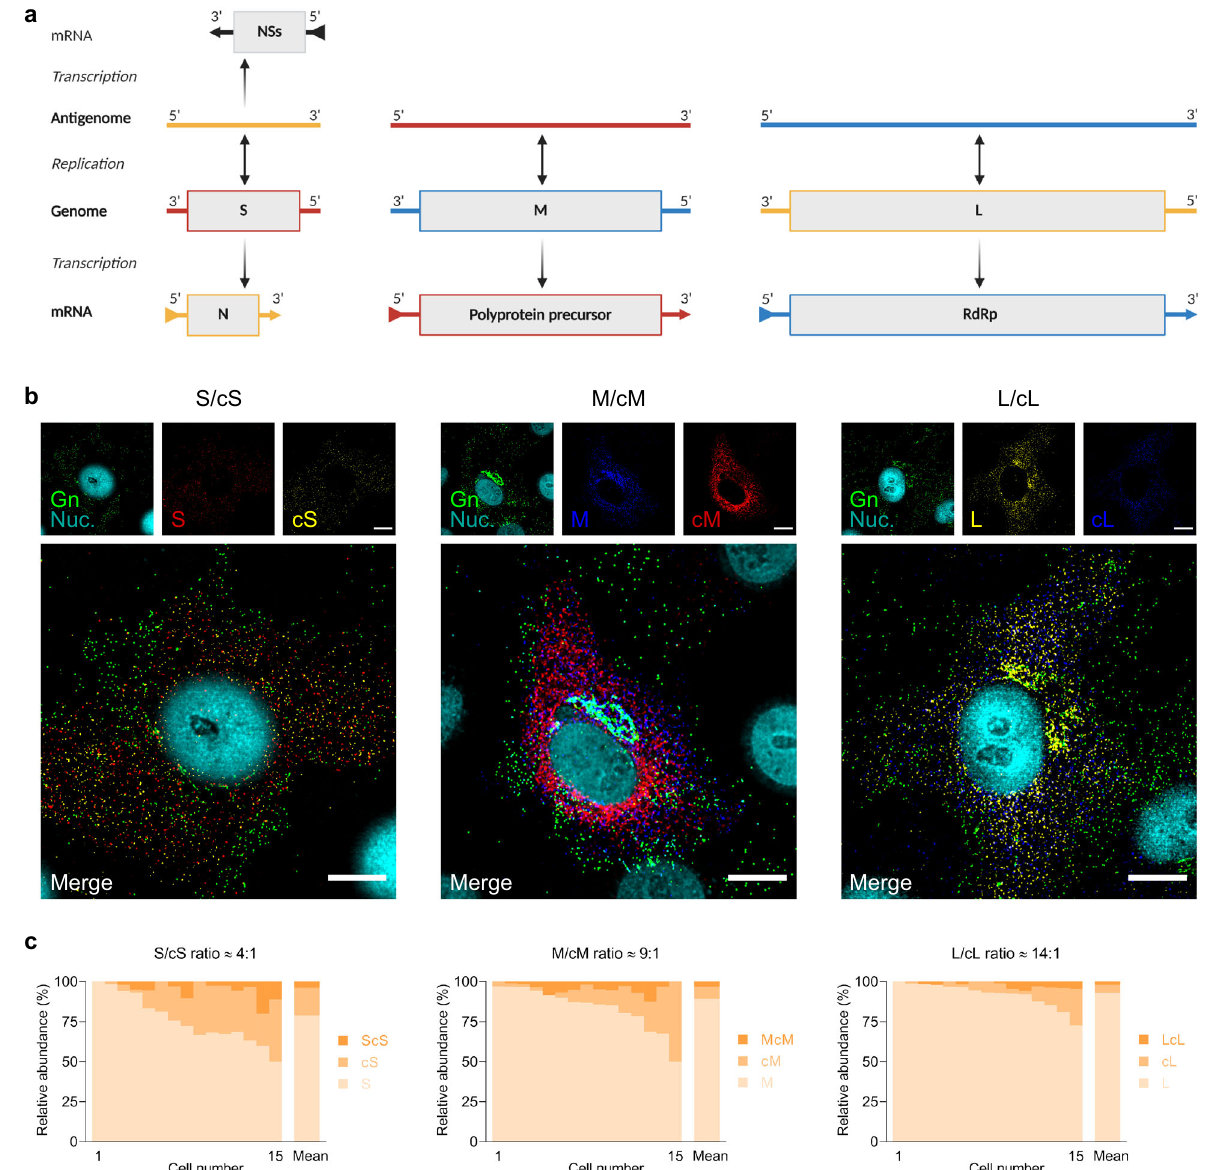
Fig. 6 Single-molecule RNA FISH-immuno fl uorescence on vRNA – cRNA pairs of RVFV-infected mammalian cells. a Schematic representation of the replication and transcription of RVFV genome segments. Here, we refer to viral genome replication intermediates (antigenomes) and mRNA transcripts as cRNAs. RVFV S segment uses an ambisense coding strategy to generate mRNAs from both the genomic-sense and antigenomic-sense RNAs. b Visualization of vRNPs, cRNAs and progeny virions of RVFV-infected cells. Vero E6 cells were infected with RVFV (MOI 0.75-1.00) and cells were fi xed at 8 – 10 h post infection. Samples were hybridized against paired targets (i.e., S-cS segments, M-cM segments and L-cL segments). The S segment (N gene; red), M segment (polyprotein gene; blue) and L segment (RdRp gene; yellow) were hybridized using probe sets labeled with CAL Fluor Red 610, Quasar 670 and Quasar 570, respectively. The cS segment (N gene; yellow), cM segment (polyprotein gene; red) and cL segment (RdRp gene; blue) were hybridized using probe sets labeled with Quasar 570, CAL Fluor Red 610 and Quasar 670, respectively. Progeny RVFV particles (green) were detected with antibody 4-D4 48 targeting the Gn glycoprotein in combination with Alexa Fluor 488-conjugated secondary antibodies. Cell nuclei (cyan) were visualized with DAPI. Individual spots, each representing either a vRNP, a cRNA or a virus particle were detected, counted and assessed for co-localization in ImageJ with the plugin ComDet. Main images are merged maximum intensity projections of four channels (individual channels shown on top). Due to a higher fl uorescence intensity of the green channel compared to the other channels, spots co-localizing with the glycoprotein may sometimes appear masked and not entirely evident in merged images. Scale bars, 10 µ m. c Quanti fi cation of the S, M, L vRNPs and their corresponding cRNAs in RVFV progeny virions. Genome compositions of the virions are expressed as their abundance relative to the amount of virions in which at least one vRNP or cRNA was detected. Graphs show the composition results of virions released by single cells ( n = 15 cells per combination; more than 3900 virions per combination) and means. vRNA/cRNA ratios are indicated. cS complementary S segment, cM complementary M segment, cL complementary L